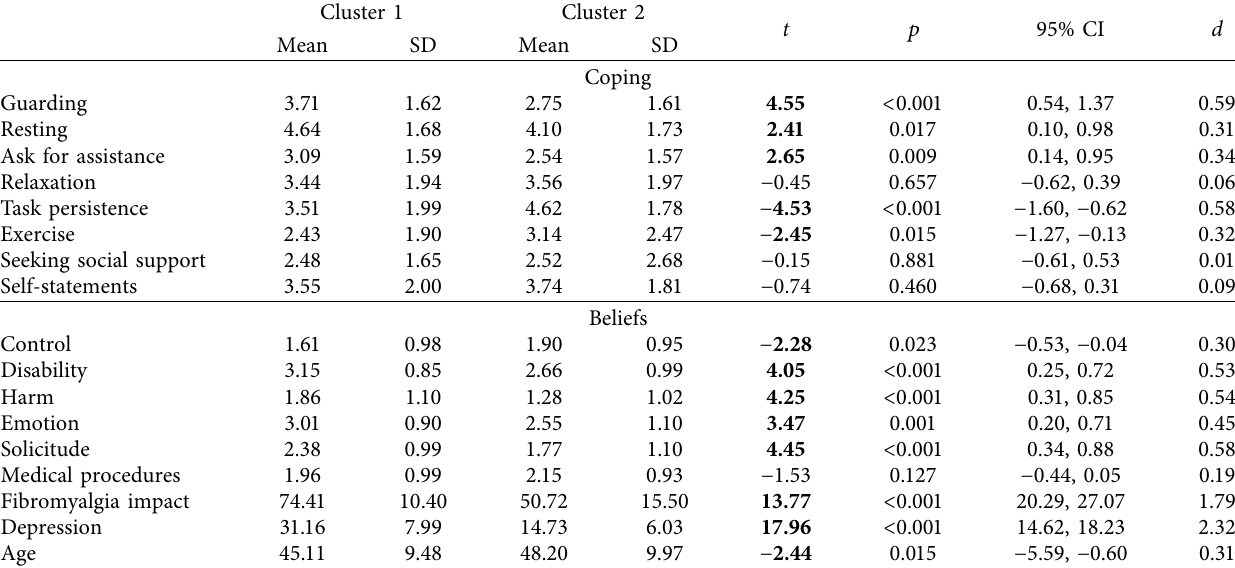
Table 1: Cluster analysis of the